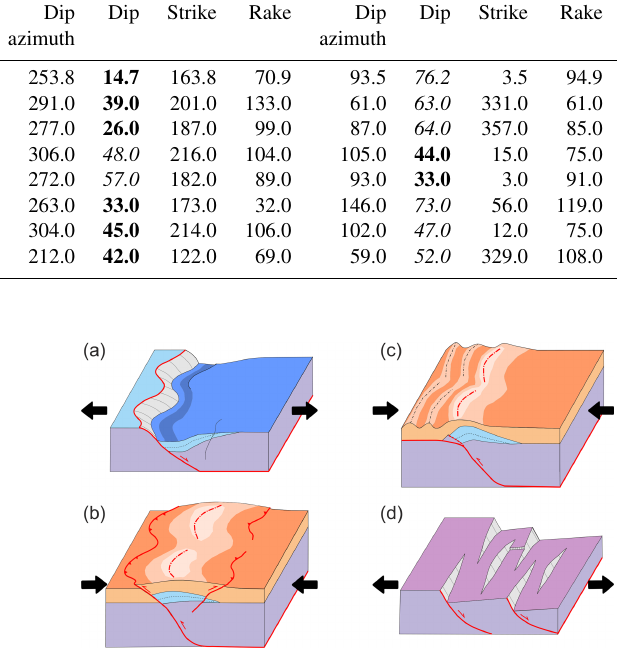
Figure 15. (a, b) Model of extension with subsequent inversion on curved linked faults (modified after Yamada and McClay, 2004). (c) Adding leading thin-skinned deformation and shortcut fault to the sketch of inverted curved linked fault system. (d) Sketch of half-graben systems with overlapping faults for anticipation of more complex subsurface geometries before